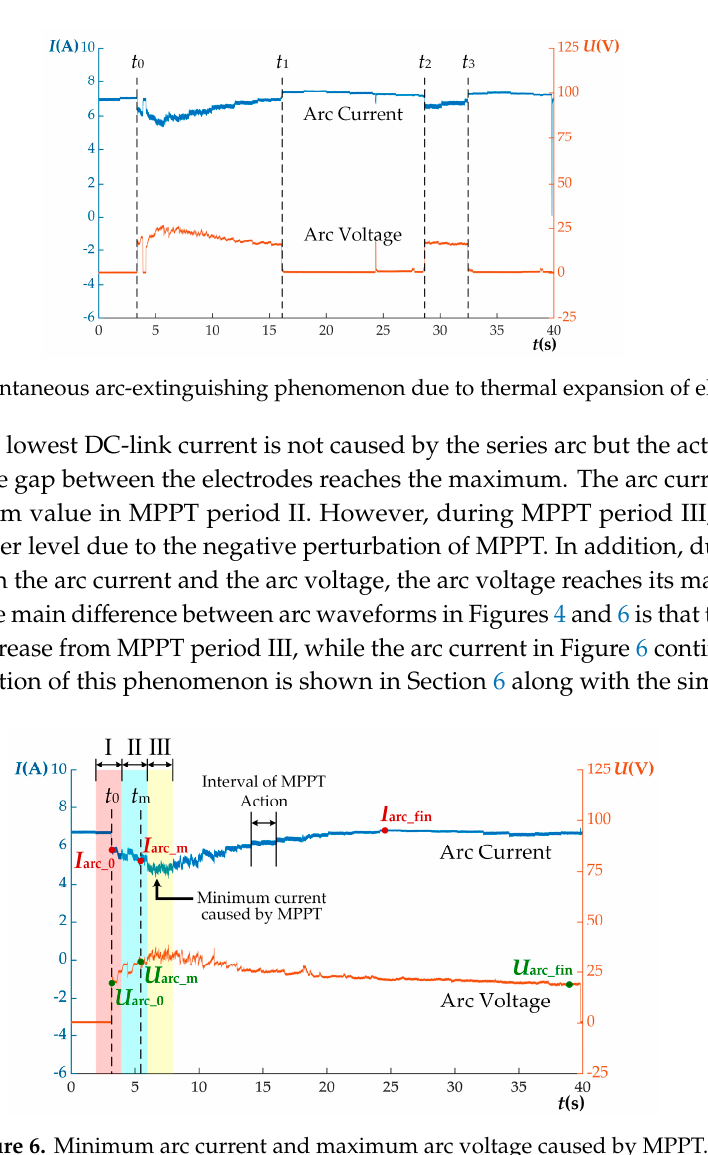
Figure 4. Typical arc voltage and current waveform changes under the action of maximum power